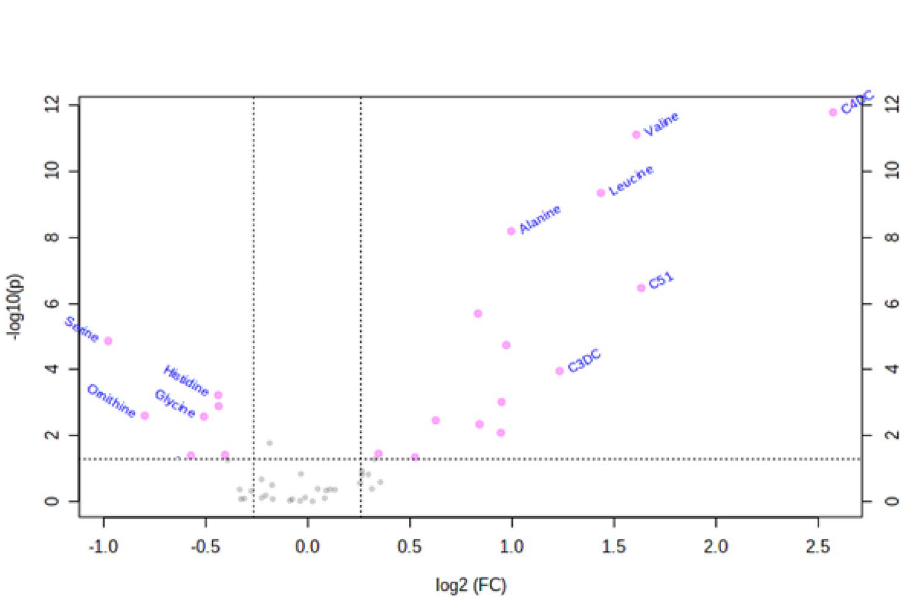
Figure 1. Volcano plot mainly displaying changed amino acids and acylcarnitines in diabetes compared to control group (Metaboanalyst software version